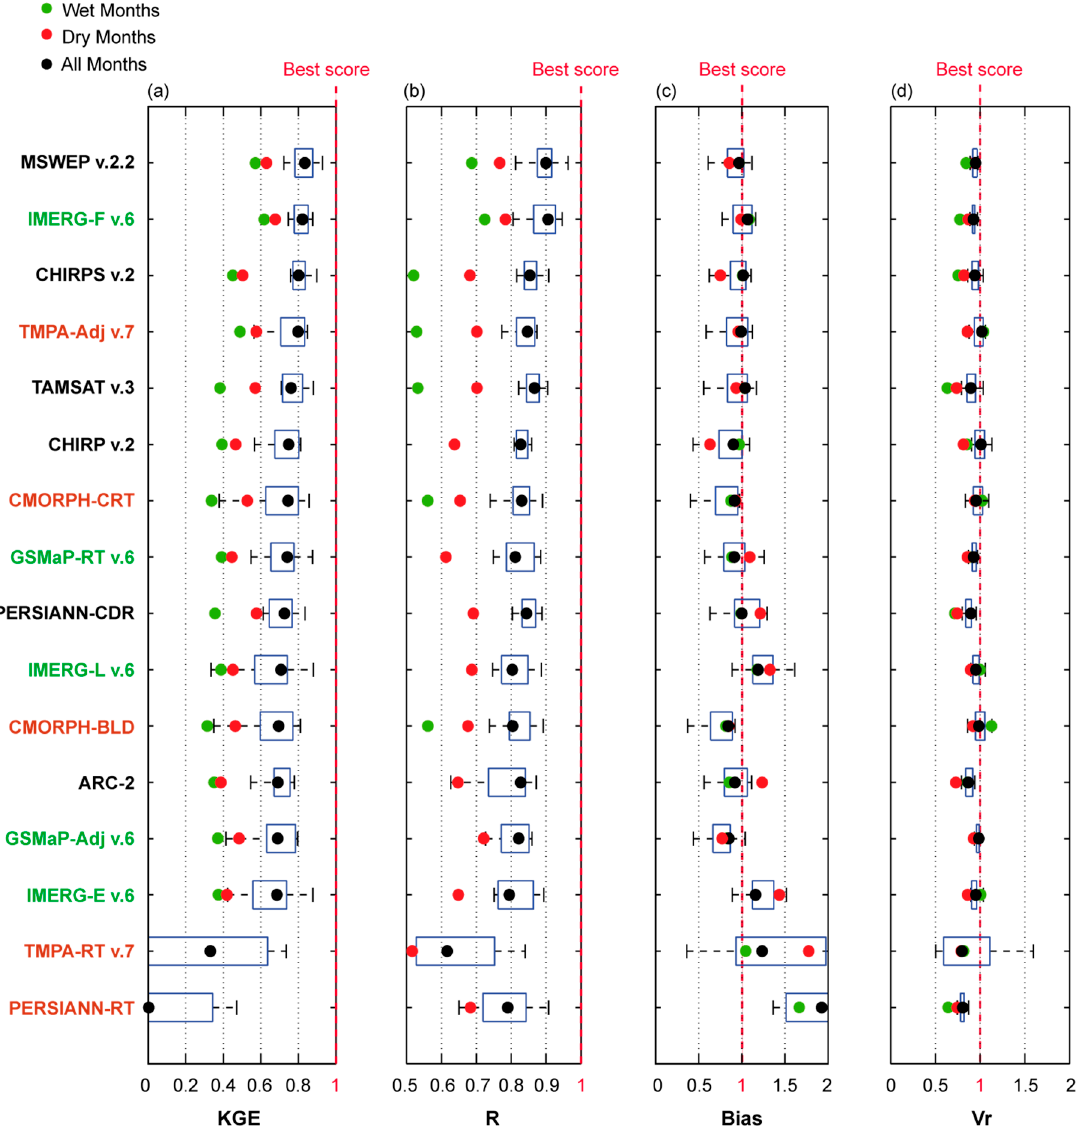
Figure 3. Box plot statistical summary of ( a ) Kling–Gupta e ffi ciency (KGE), ( b ) correlation coe ffi cient (r), ( c ) bias ( β ), and ( d ) variability ratio (Vr), based on the sixteen SPPs and eleven gauging stations across Nigeria. The performances in terms of KGE, correlation coe ffi cient, bias, and variability ratio of all SPPs across all months are highlighted in black, while their seasonal performances are highlighted in green and red for the rainy and dry seasons, respectively. The SPPs in black represent the long-term group, while the Tropical Rainfall Measuring Mission (TRMM) is in red and the Global Precipitation Mission (GPM) is in green.